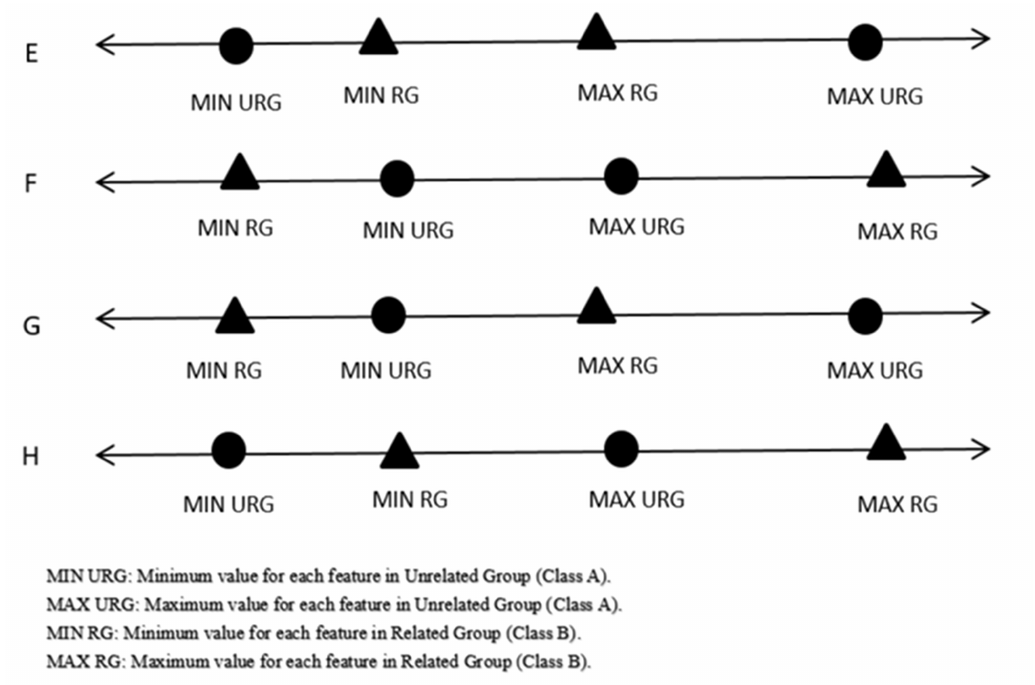
Figure 3. Overlapping cases between the feature and the same feature in the corresponding class. Now, expand the intervals, both right and left sides, by Equations (5) and (6),